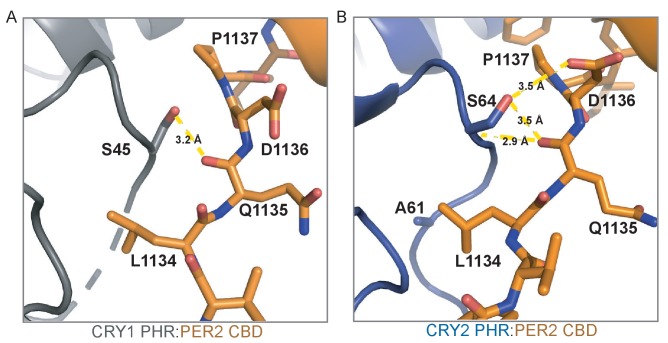
Binding to PER2 CBD rearranges the serine loops on CRY1 and CRY2.(A) Zoomed in view of the serine loop of CRY1 PHR:PER2 CBD (gray:orange). Interaction between Ser45 of CRY1 and the backbone of Gln1135 of PER2 CBD shown with yellow dashed lines. (B) Zoomed in view of the serine loop of CRY2 PHR:PER2 CBD (blue:orange). Interaction between Ser64 of CRY2 and the backbone of Gln1135 and the side chain of Asp1136 of PER2 CBD shown with yellow dashed lines.